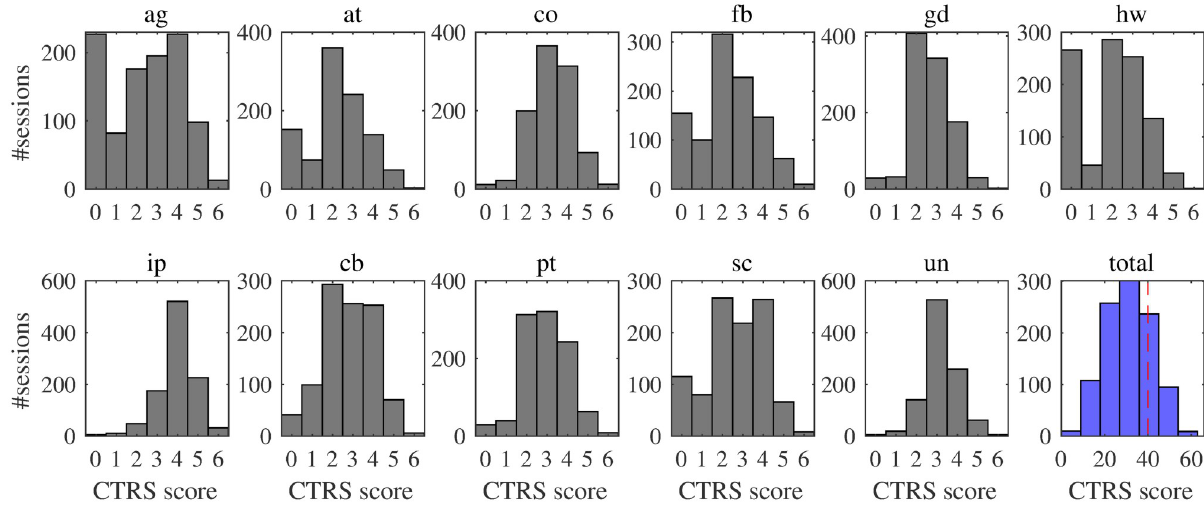
Fig 1. Distribution of the 11 CTRS codes (and the total CTRS) across the Likert scale. A total CTRS score above or equal to 40 indicates competent delivery of CBT.